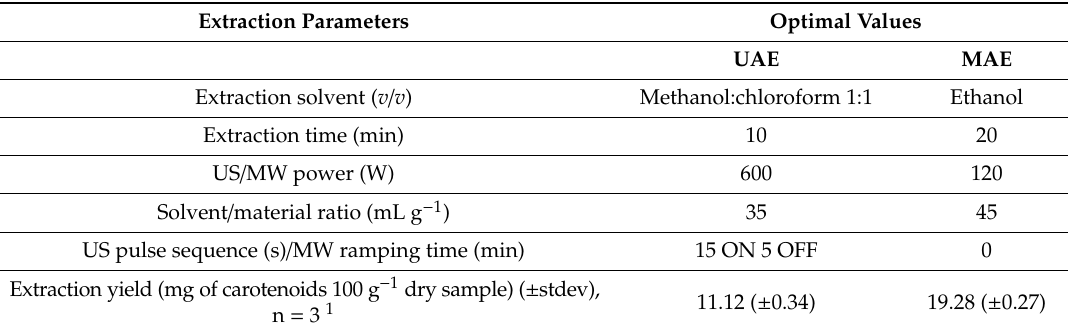
Table 1. Optimal values of UAE and MAE parameters for carotenoid recovery from apricot